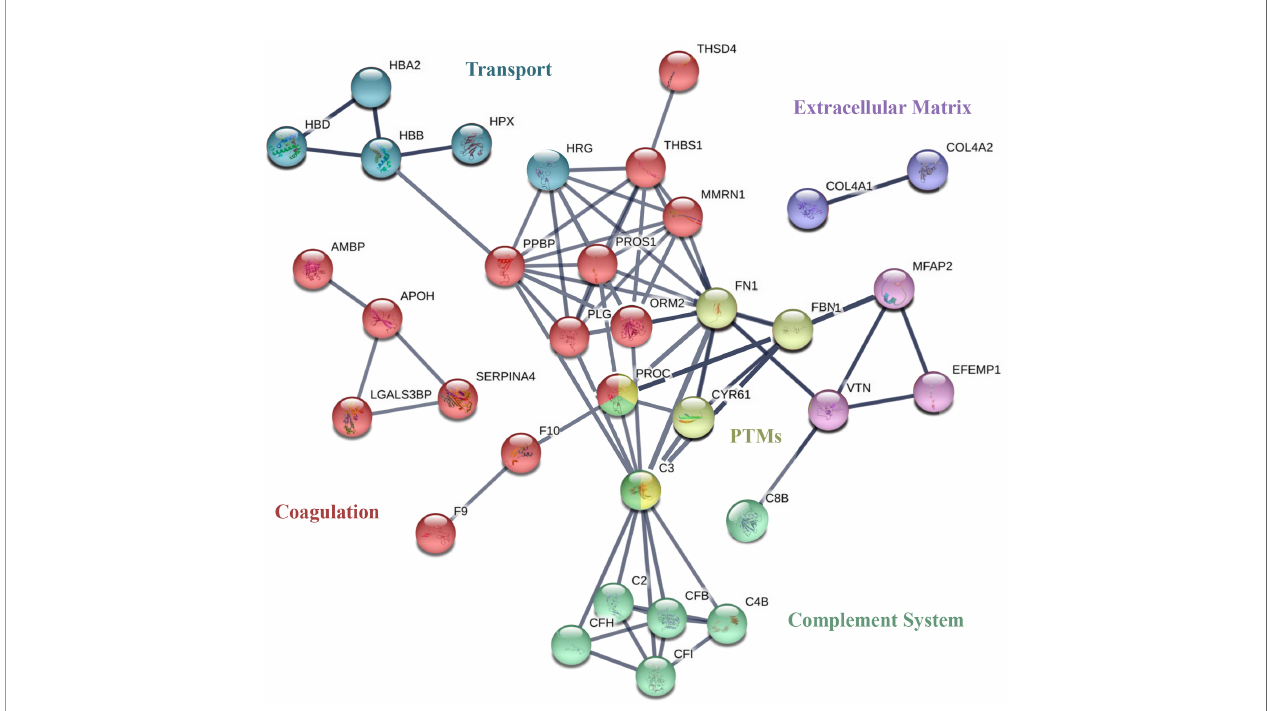
FIGURE 5 | STRING of the most relevant proteins identi fi ed in EC-anaphylaxis and EC-control systems. Network analysis of the selected proteins found to be differential. The nodes of the networks represent individual proteins and the lines depict associations between proteins upon functional enrichment